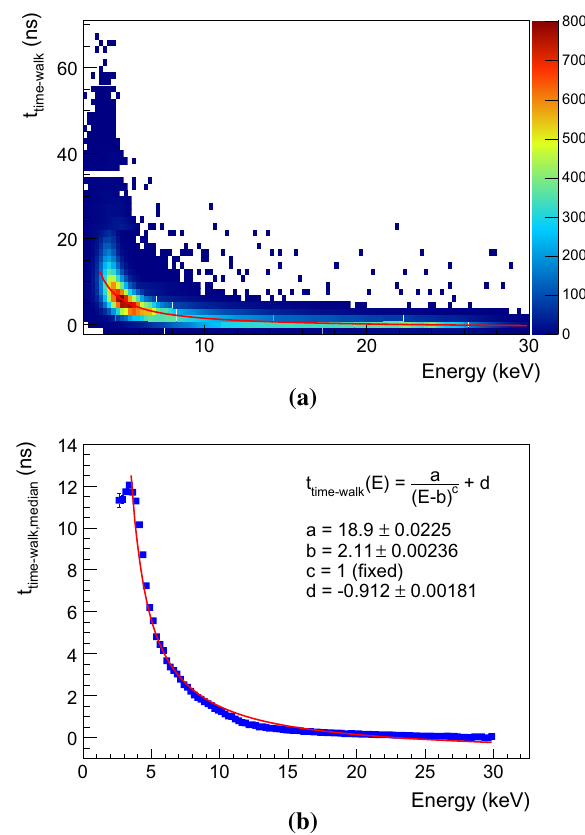
Fig. 4 a Scatter plot of delays due to the time-walk effect in depen- dence of the energy of pixels in a 4-pixel cluster with one pixel measur- ing 30–32keV. The detector was irradiated by 59.6keV gamma rays; b delay due to time-walk as a function of energy measured in the pixels. The subtraction of the value calculated for the pixel energy according to the fit curve corrects for the time-walk. Deviations of the data points from the fit are significantly smaller than the granularity of the time measurement (i.e. 1.56ns). The fit is also indicated by the red line in a